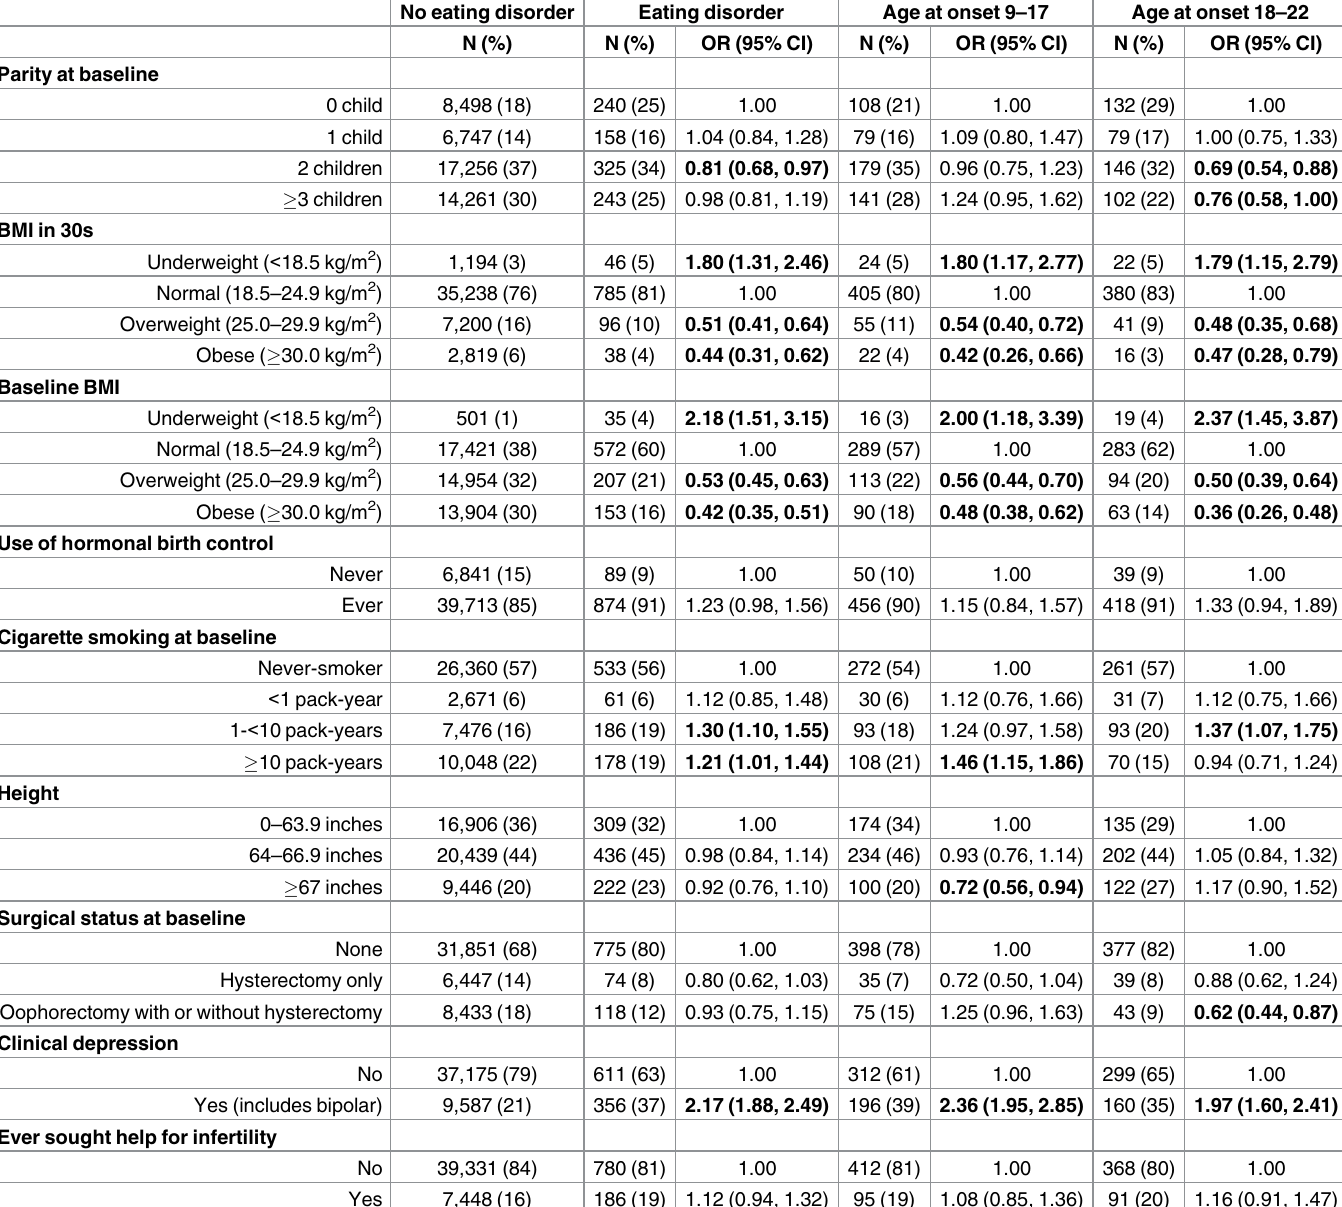
Table 3. Odds ratios (ORs) and 95% confidence intervals for the association between eating disorder status (Ever ages 9–22, Ever ages 9–18, or Ever ages 18–22)and health-related outcomes (n =